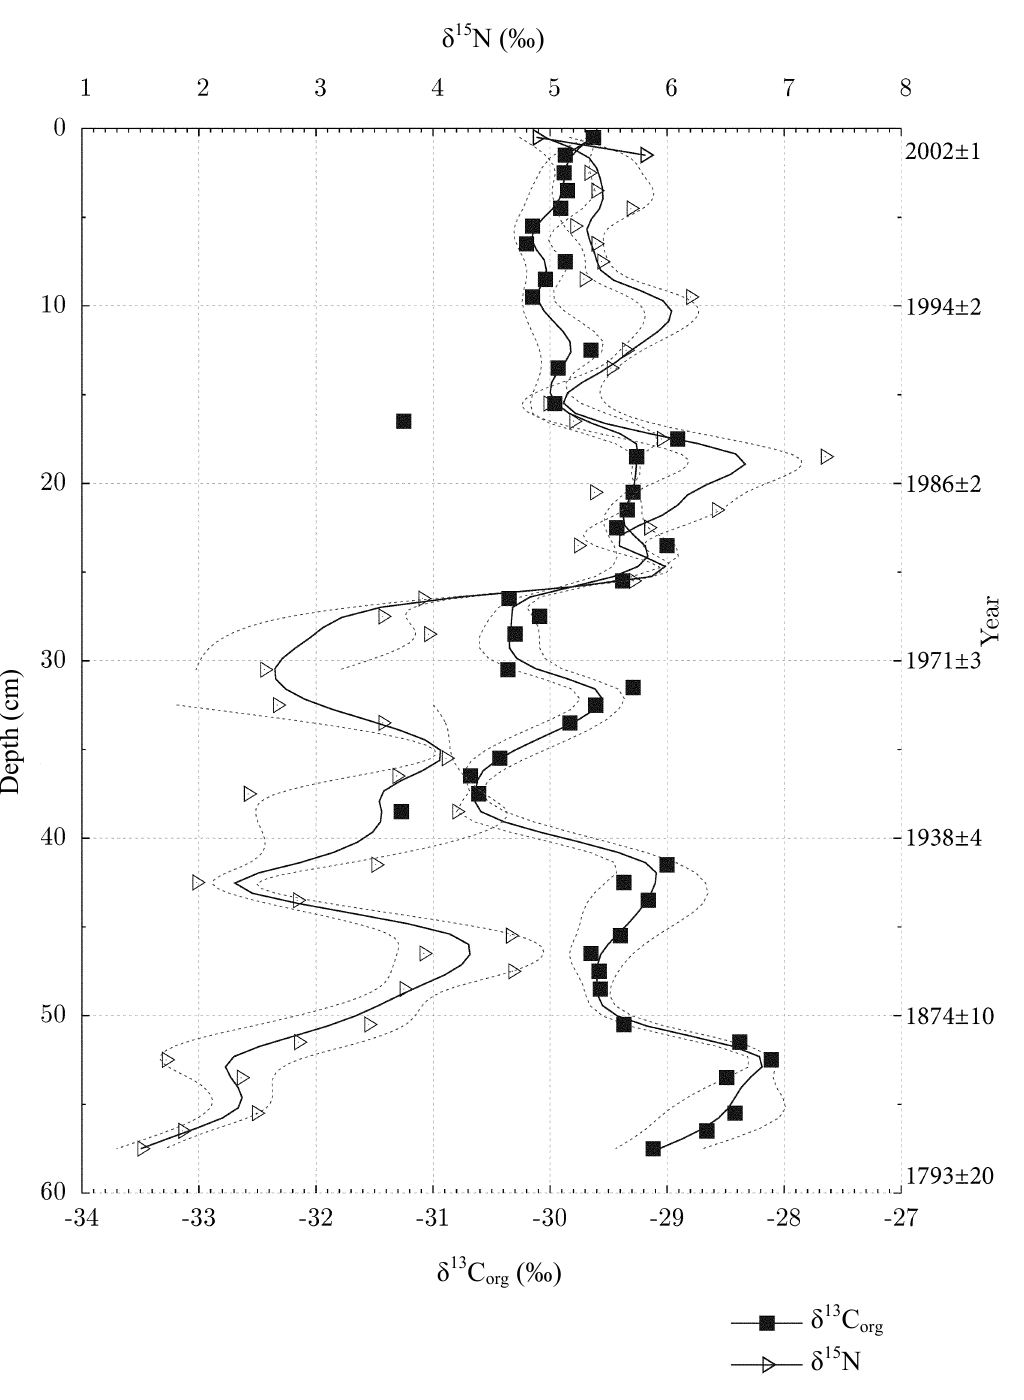
Fig. 5. Variation in  13 C in organic fraction and total  15 N values in the sediment